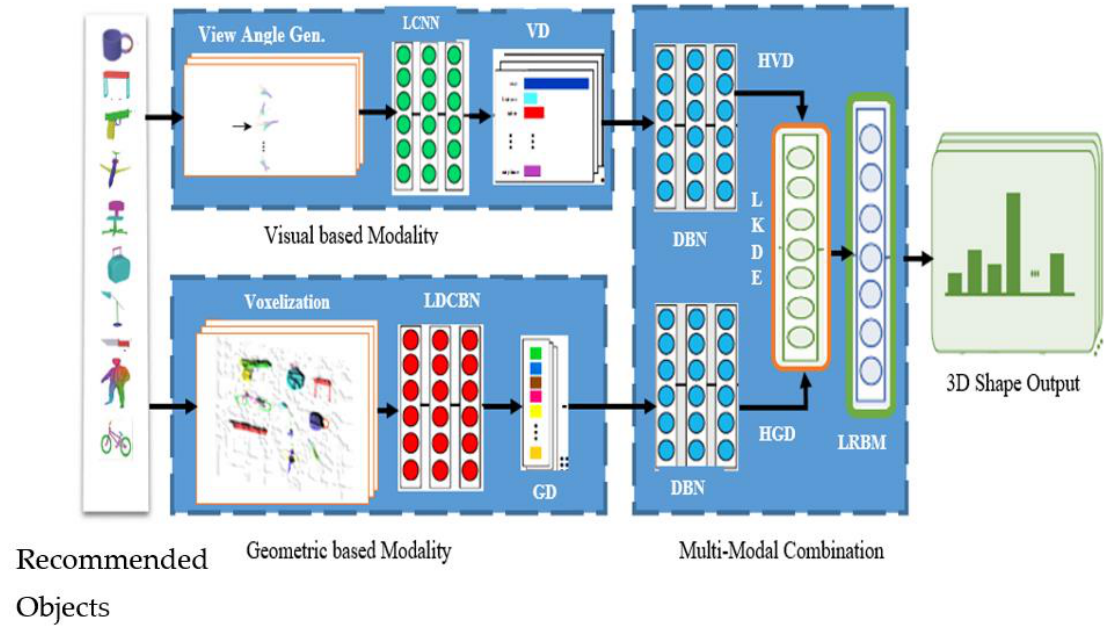
Figure 1. The Framework of the proposed model.